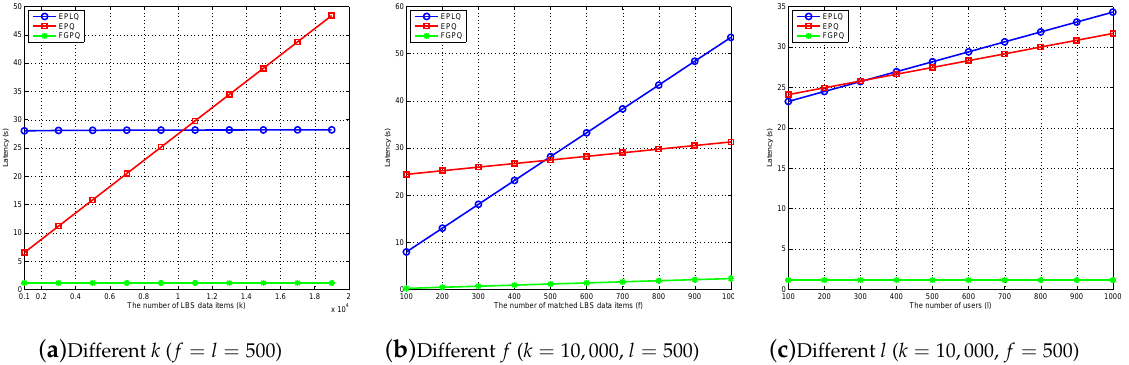
Figure 2. The comparison of latency for location-based service